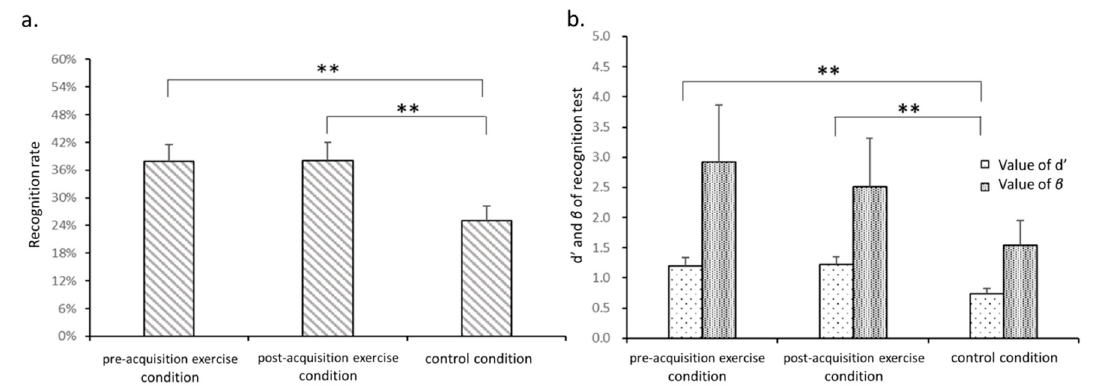
Figure 5. Comparison of word recognition rate ( a ) and of d’ and β values ( b ) in the DM experiment across experimental conditions; ** p < 0.01.